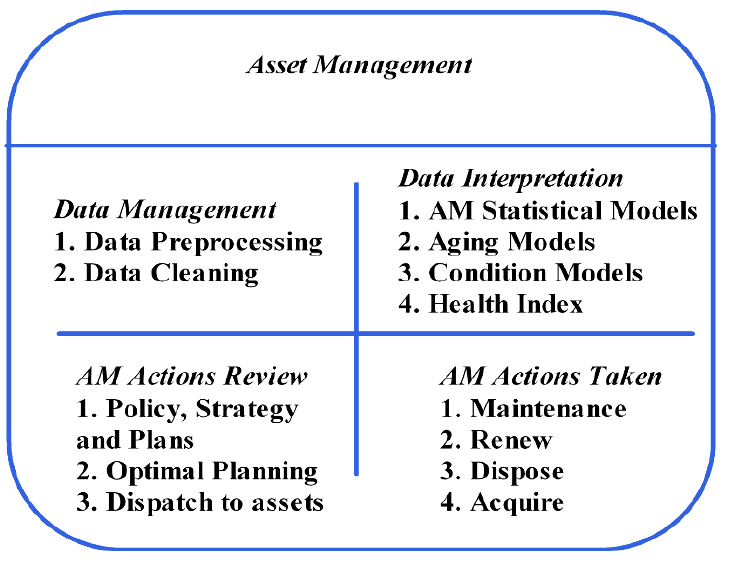
Figure 2. Typical structure of asset management